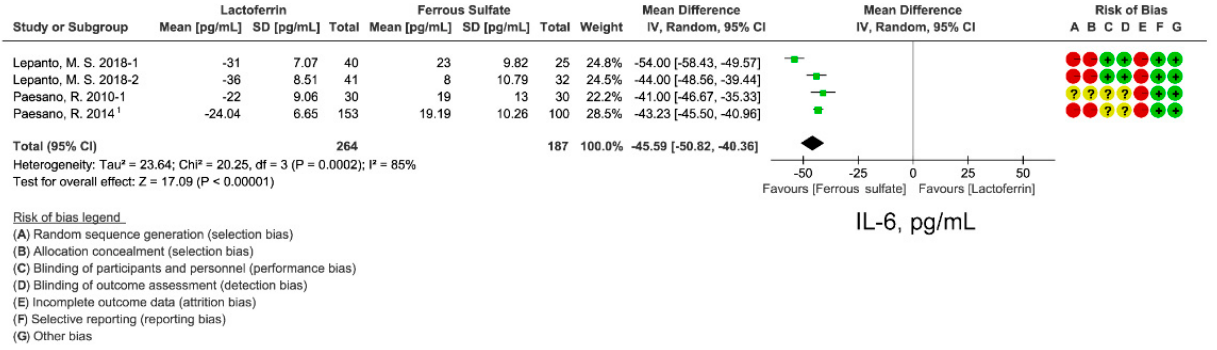
Figure 6. Effect of lactoferrin and ferrous sulfate on serum IL-6 levels. 1. Mean and SD were estimated from histogram. Risk of bias legend: A = random sequence generation (selection bias); B = allocation concealment (selection bias); C = blinding of participants and personnel (performance bias); D = blinding of outcome assessment (detection bias); E = incomplete outcome data (attrition bias); F = selective reporting (reporting bias); G = other bias. Data expressed as weighted mean difference (95% CI). IV, inverse variance.